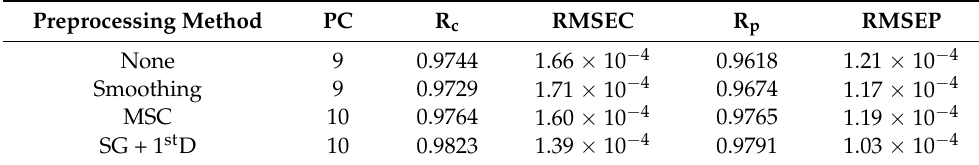
Table 1. Results of the PLS model of THz spectra by different preprocessing methods.